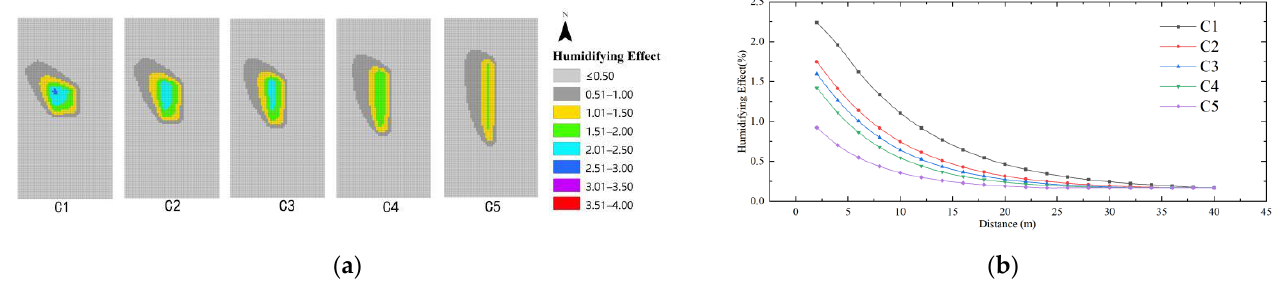
Figure 17. Humidifying effect of shape index of the water body: ( a ) Impact distribution map; ( b ) Impacts with distance.